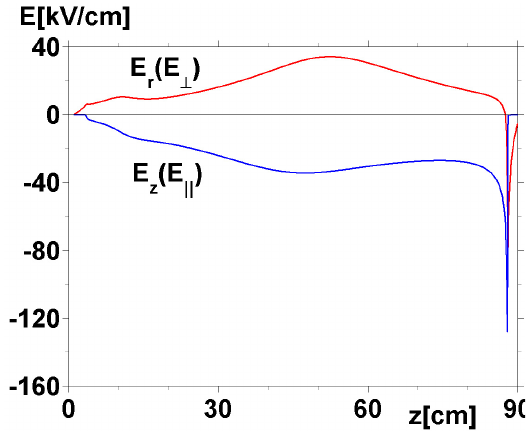
FIG. 13. (Color) Values of the components of the electric field with 2.2 MV applied voltage 10 (cid:2) m below the monolithic insulator in Fig. 12 vs z